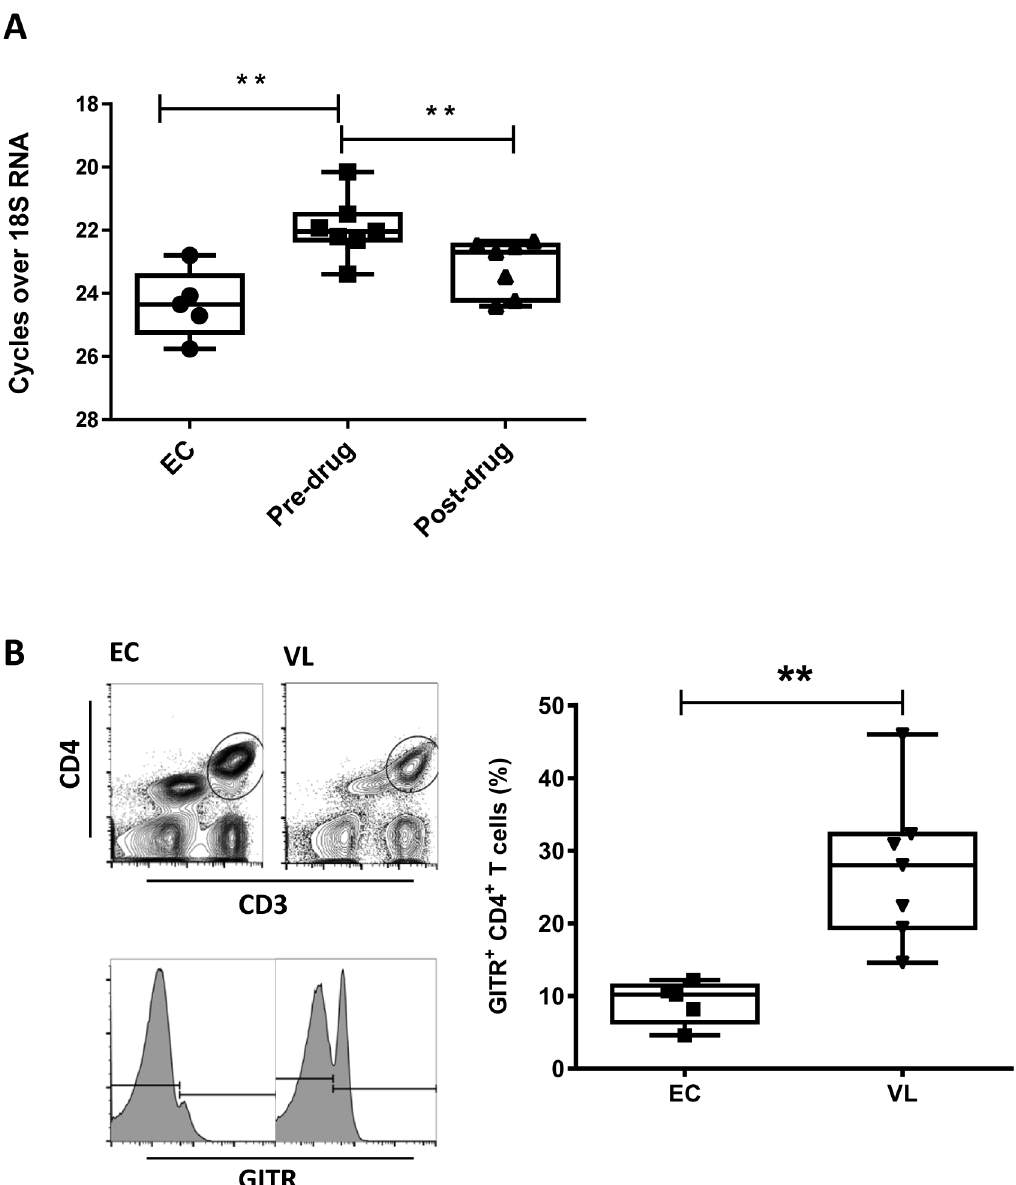
Fig 1. Increased frequency of GITR-positive CD4 + T cells in VL patients. A. The relative expression of GITR mRNA in PBMC of VL patients was measured by qPCR before treatment (Pre-drug; n = 7) and 28 days after the commencement of treatment (Post-drug; n = 7),as well as in healthy endemic control (EC; n = 5) samples. B . PBMC ’ s from VL patients before drug treatment (VL; n = 7) and healthy endemic controls (EC; n = 5) were gated on CD3 ε + CD4 + T cells and the frequency of GITR-positive CD4 + T cells was measured by FACS. Box and whisker plots show the box extending from the 25 th to 75 th percentiles with the line in the middle of the box representing the median and whiskers going down to the smallest value and up to the largest. Statistical differences of p < 0.05 ( * ) and p < 0.01 ( ** ) are